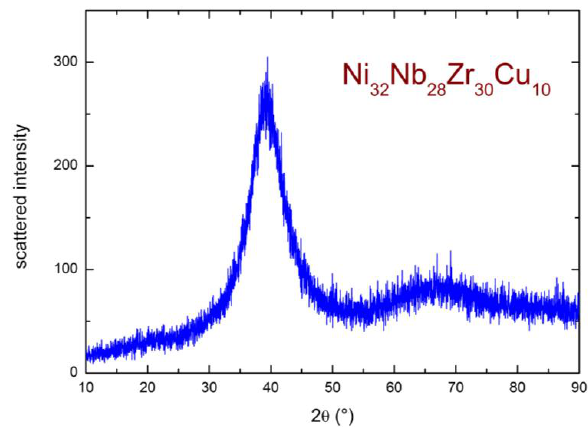
Figure 4. XRD spectrum of the pristine Ni 32 Nb 28 Zr 30 Cu 10 membrane measured at room temperature in a He atmosphere.